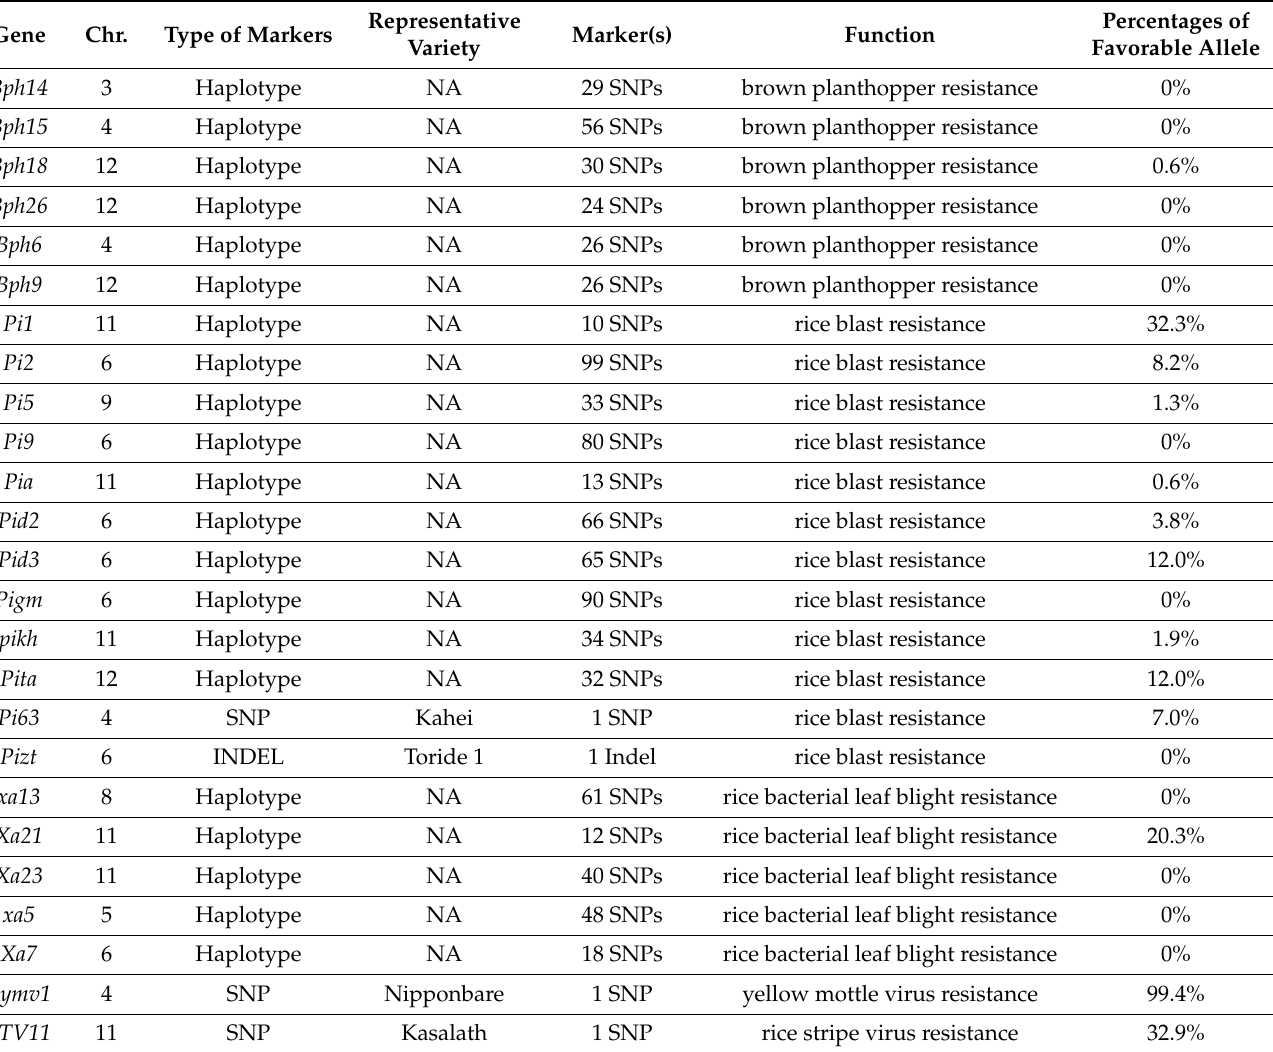
Table 1. Functional analysis of genes in response to bio-stress resistance in the collection of rice